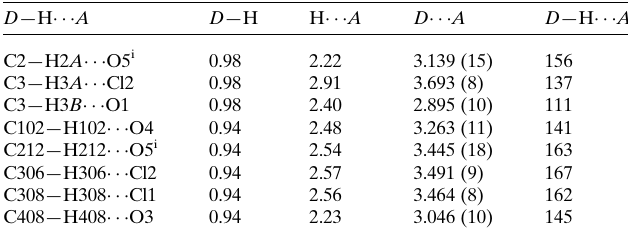
Table 3 Hydrogen-bond geometry (A˚ , (cid:3) ) for 5